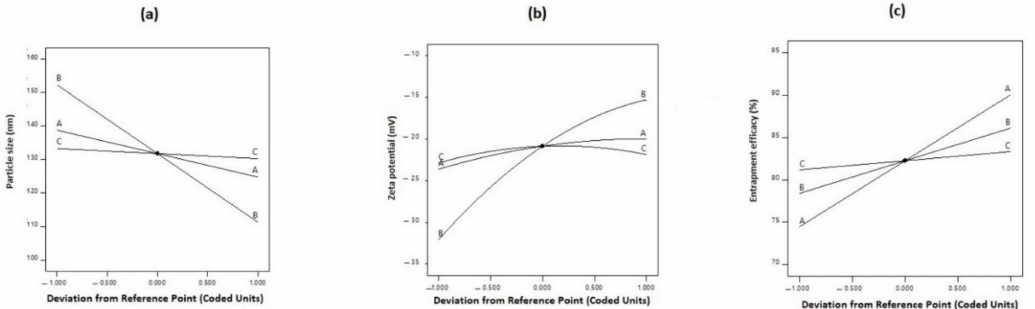
Figure 2. Perturbation plot of effect of (A) oil concentration (%), (B) surfactant concentration (%), and (C) sonication time (min) on ( a ) particle size, ( b ) zeta potential, and ( c ) entrapment efficacy (%). Surfactant concentration (B) had a prominent main linear effect on particle size and quadratic nonlinear effect on zeta potential, while oil percentage (A) had a prominent main linear effect on entrapment efficacy